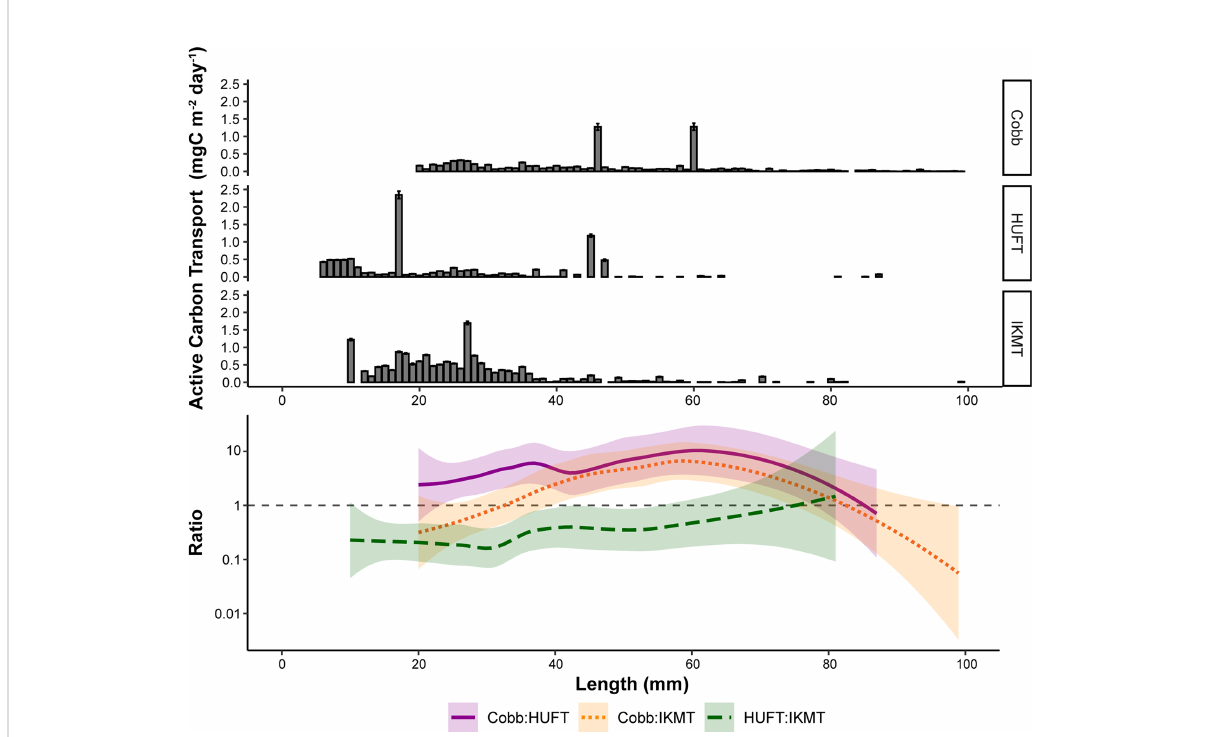
FIGURE 4 Top: Mean active carbon transport of micronekton by length for the three different sampling gears (Cobb, HUFT, IKMT); bars indicate ± standard error of the mean. Bottom: log 10 -transformed pairwise ratios of total active carbon transport between the three different sampling gears by length with a LOESS (locally estimated scatterplot smoothing) fi t. Shaded areas represent 95% con fi dence intervals, while the dashed gray line represents a pairwise ratio of 1 (i.e., estimates from both gears are